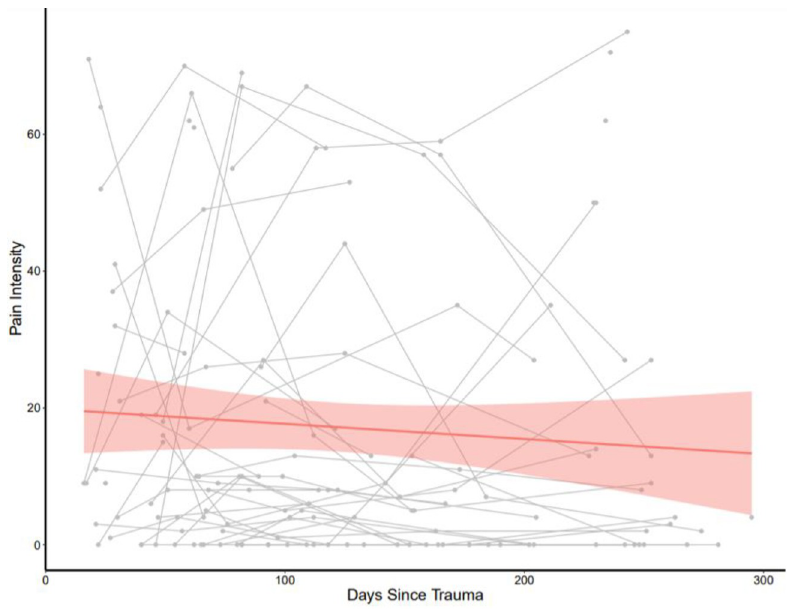
Fig 1. Reduction of pain intensity Short-Form McGill Questionnaire visual analog scale over time in young women with recent interpersonal violence. Red shade represents 95% CI. Gray lines represent individual changes in pain interference over time.